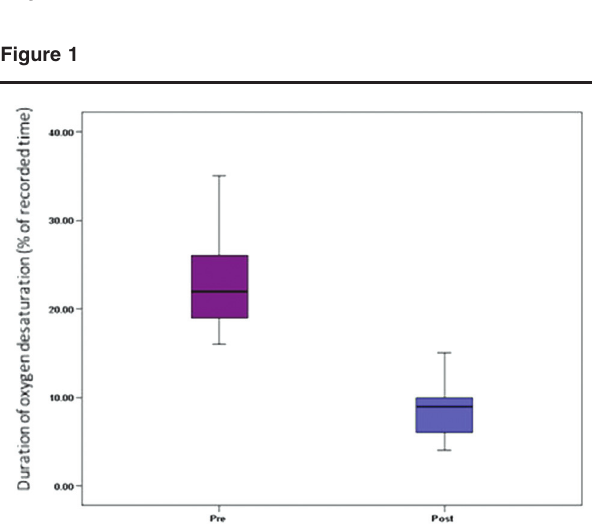
Comparison between duration of oxygen desaturation (percentage of recorded time) before and after therapeutic intervention in group II